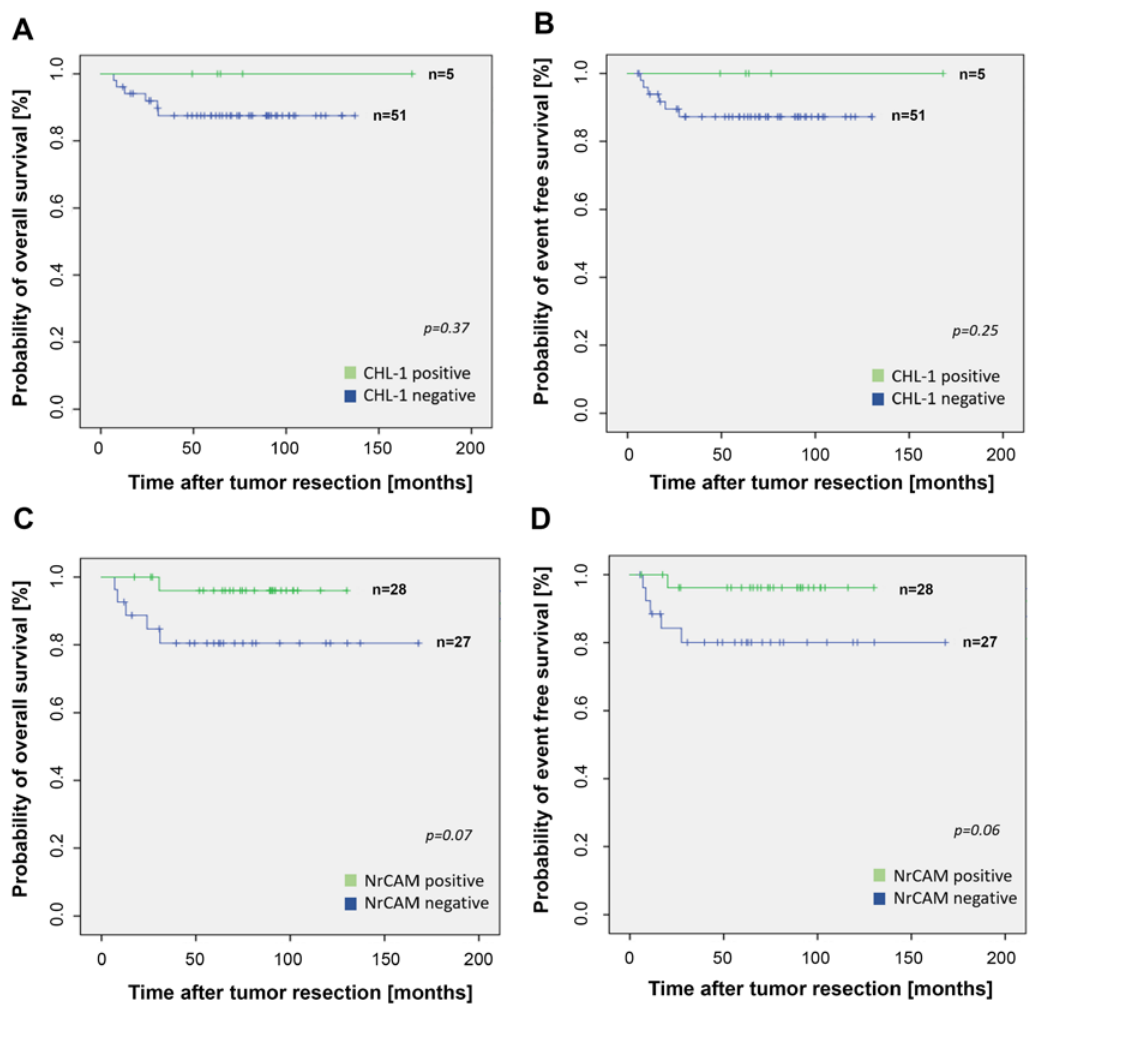
Figure 2: Kaplan-Meier survival curves for overall and event-free survival. No association was found for CHL1-expression (A/B). Survival rates were better by trend in children with NrCAM positive tumors (C/D) but without statistical significance (p=0.07 and